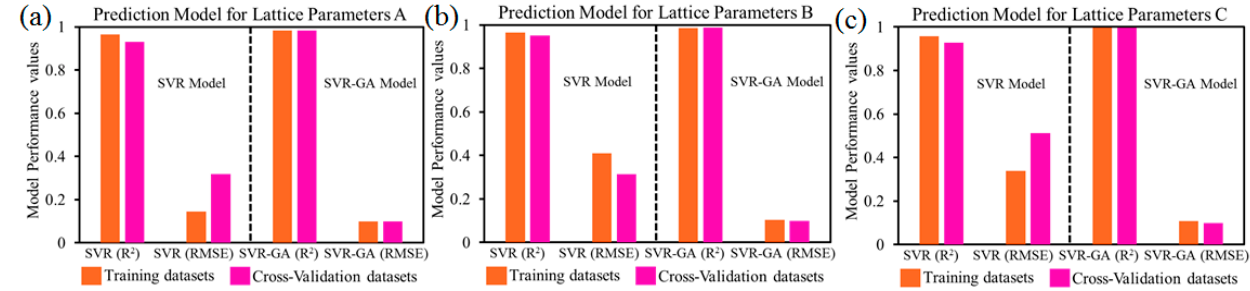
Figure 12. The performance evaluations of the SVR and SVR-GA modelling systems ( a ) for the lattice parameters A, ( b ) for the lattice parameters B, and ( c ) for the lattice parameters C.